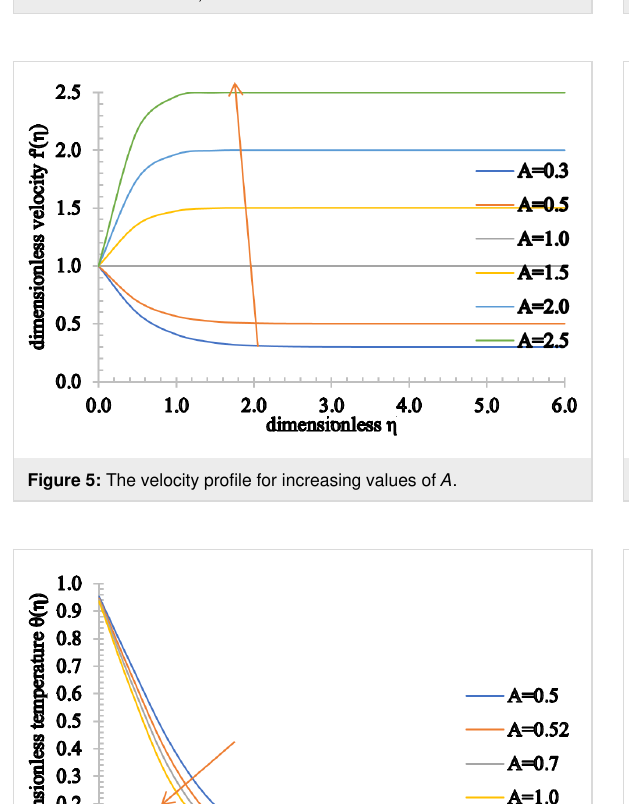
Figure 4: The concentration profile of a fluid for increasing values of the Hartmann number, Ha .